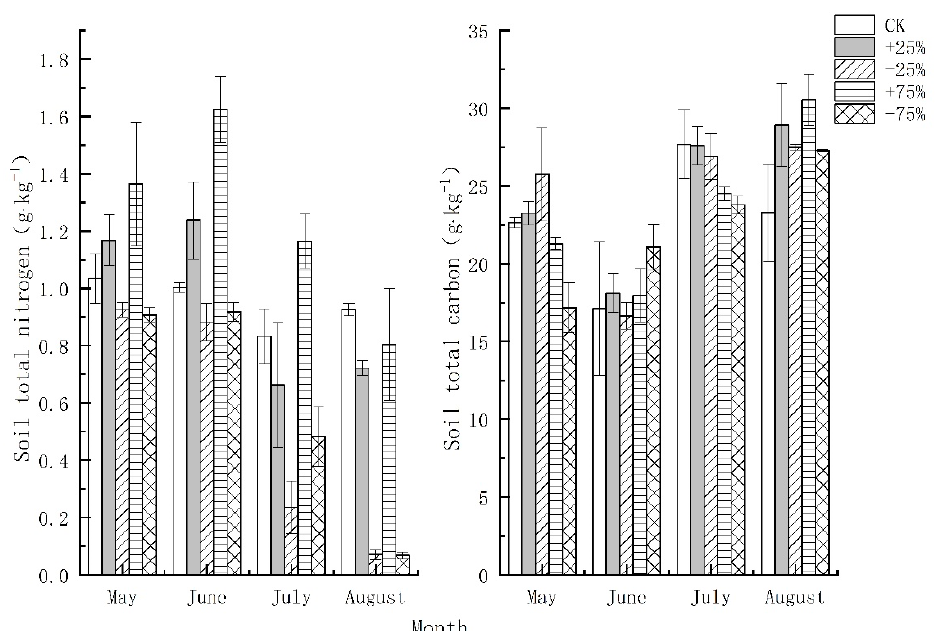
Figure 6. Changes of the soil total nitrogen and total carbon in the Niaodao Lakeside wetland during the growing season under different rainfall treatments. Table 3. Physical and chemical properties of the surface soil under different rainfall treatments dur- ing the growing season.